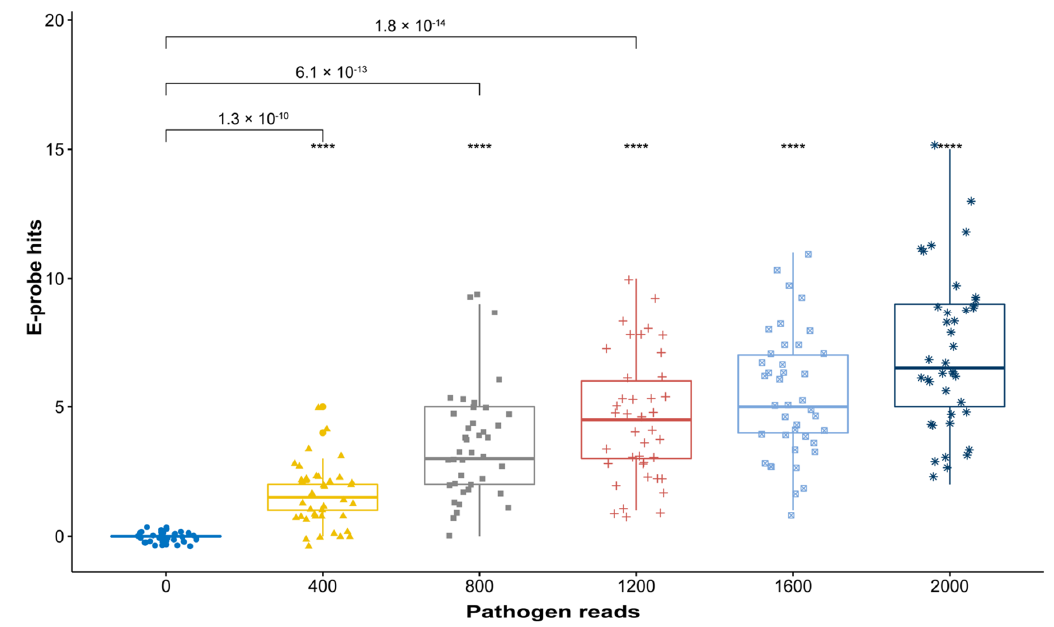
Figure 2. In silico pathogen (Grapevine Leafroll associated Virus 3, GLRaV-3) titer response with 15 e-probes. Boxplots depict e-probe hits distribution ( y -axis) vs. a gradient pathogen titer (# reads of pathogen in the metagenome ( x -axis)) in the simulated metagenome. With 15 e-probes, the p -value that determines true positives significantly distinguishes positive from the known negative control ( p -value = 1.3 × 10 −10 ). Statistical value meanings in the figure are ns: not significant, ****: p ≤ 0.0001. Boxplot colors represent a different pathogen read number in the metagenome and are labeled in the x axis.